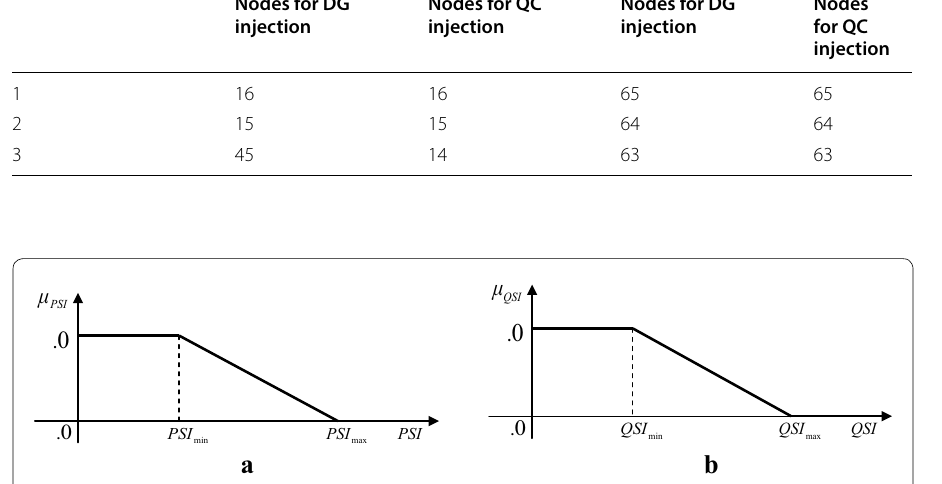
Nodes for QC injection